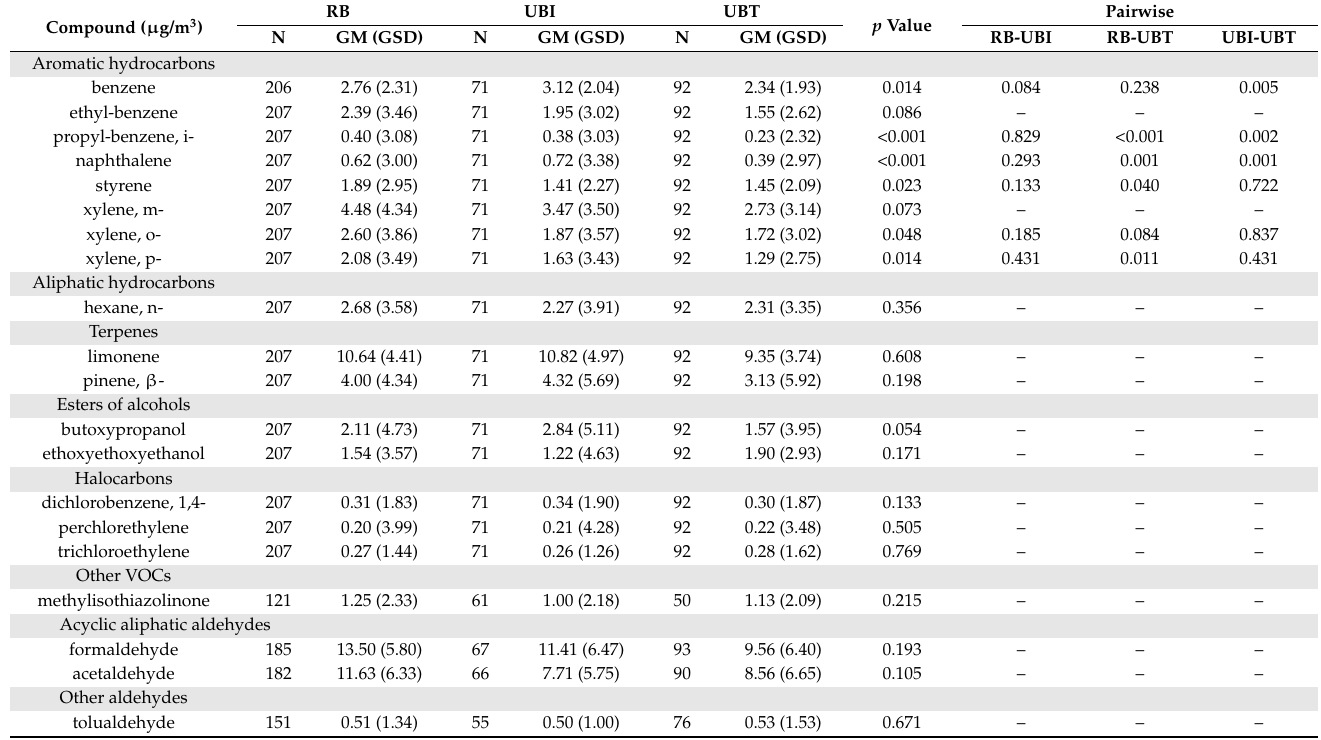
Table 2. Concentration of selected hazardous air pollutants, by